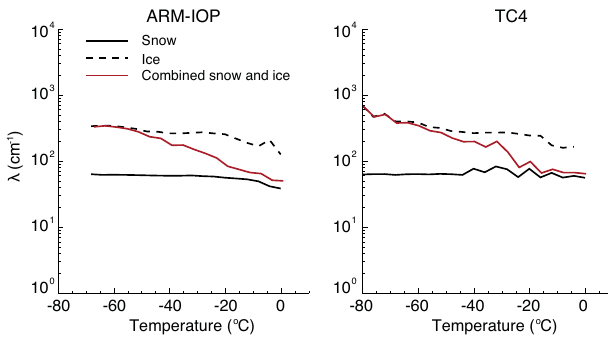
Figure 3. Modeled slope parameter, for ice and snow individually. Also shown is the combined snow and ice slope parameter, as shown in Fig.